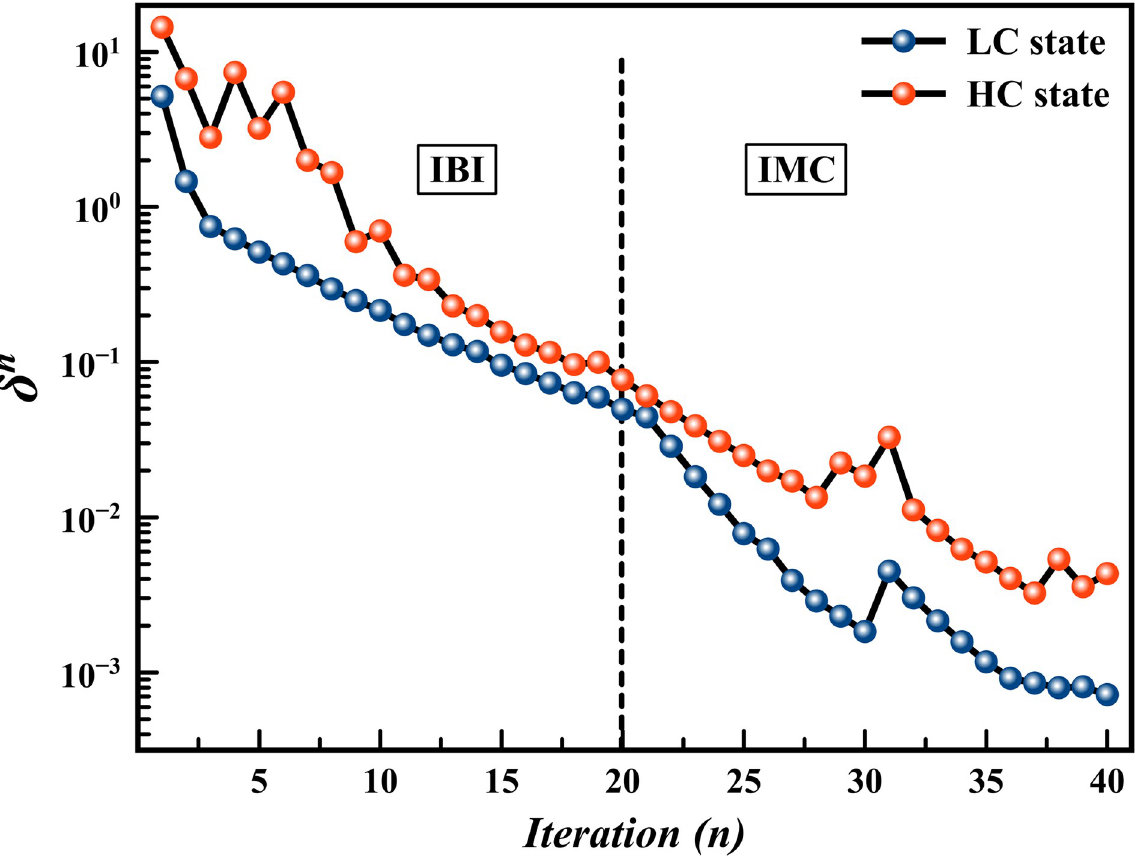
Fig 3. Convergence of IBI/IMC process. Total deviation of the simulated CG distribution functions from their reference values during the iterative processes.